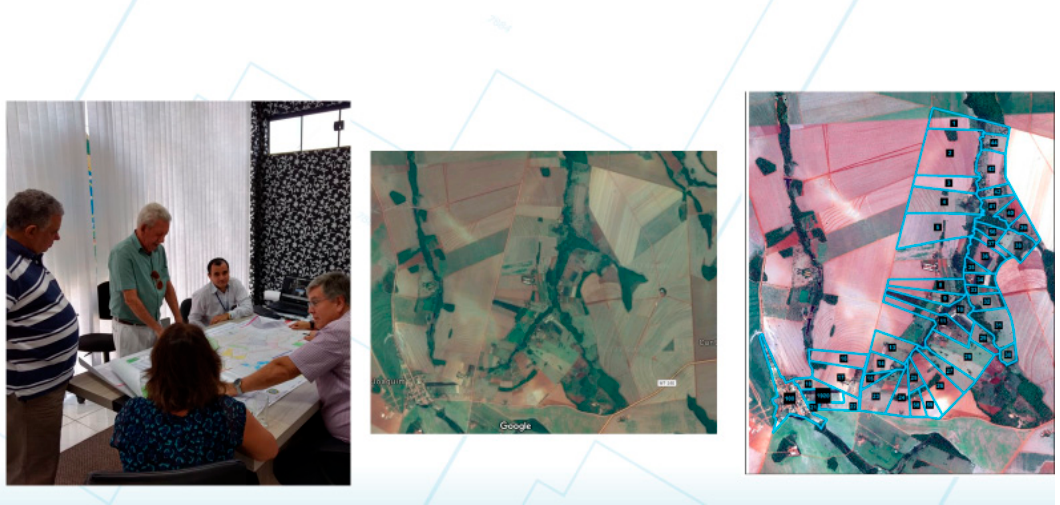
Figure 6. Images of the fit-for-purpose experience in Tangará da Serra.